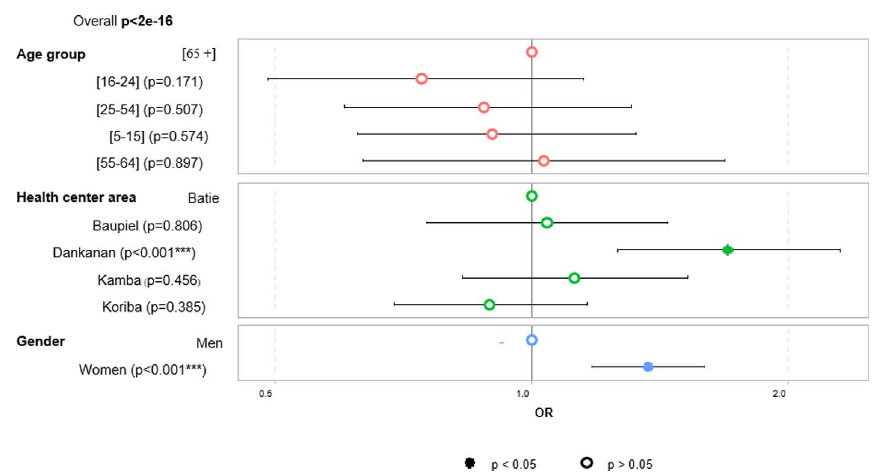
Figure 4. Multivariable logistic regression showing the association between overall rapid diagnostic test positivity and age group, health center area, and gender.